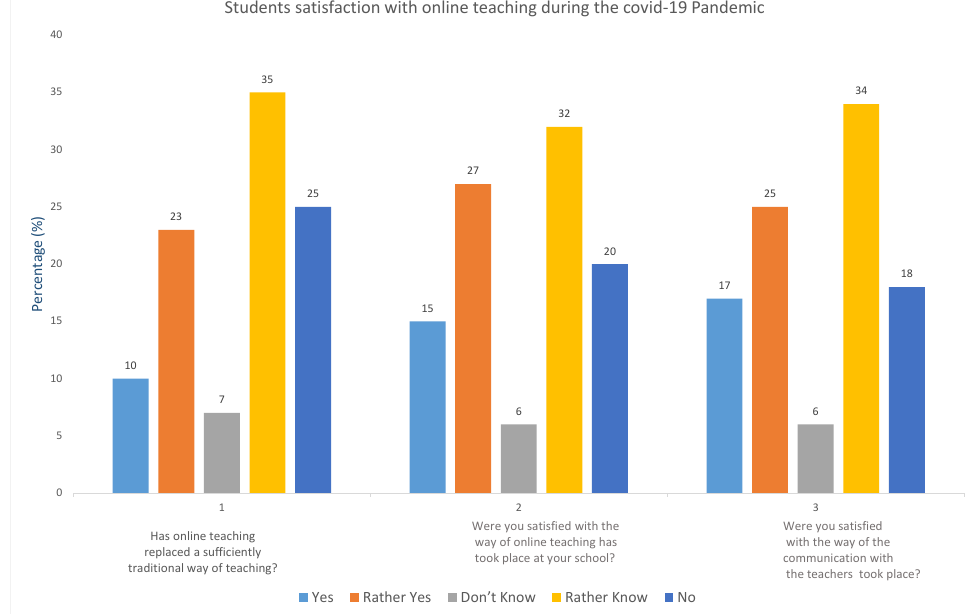
Figure 7. Student’s satisfaction with online teaching mode